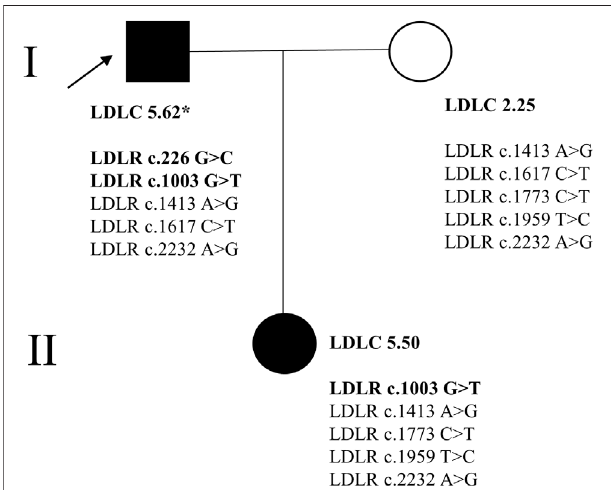
FIGURE 1 | The family tree of the proband. * signi fi ed that the patient was taking the lipid-lowering drug (atorvastatin 20 mg); → represented the proband. In the current study, the background of the FH patients ’ (I-1, II-1) picture was blackened. The disease-causing variants in LDLR were